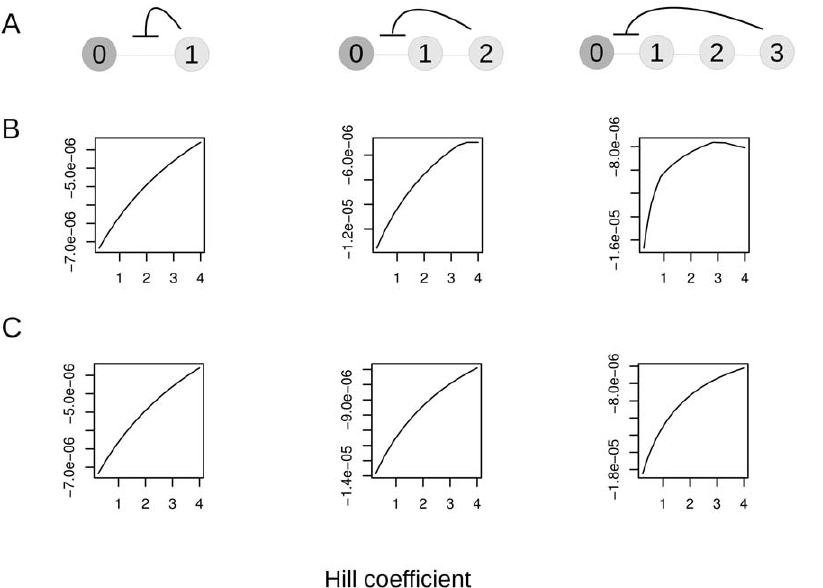
Figure 4. Several longer pathways where the best fitness is not given with the maximum Hill coefficient. A. Pathways with 2, 3 and 4 molecules. B. Plots of fitness vs. Hill coefficient of inhibitor binding given homeostasis on all molecules. C. Fitness vs. Hill coefficient given homeostasis acting only on the tip molecule. Fitness reflects the deviations of molecules from their targets and is in units of concentration (see text for definition).